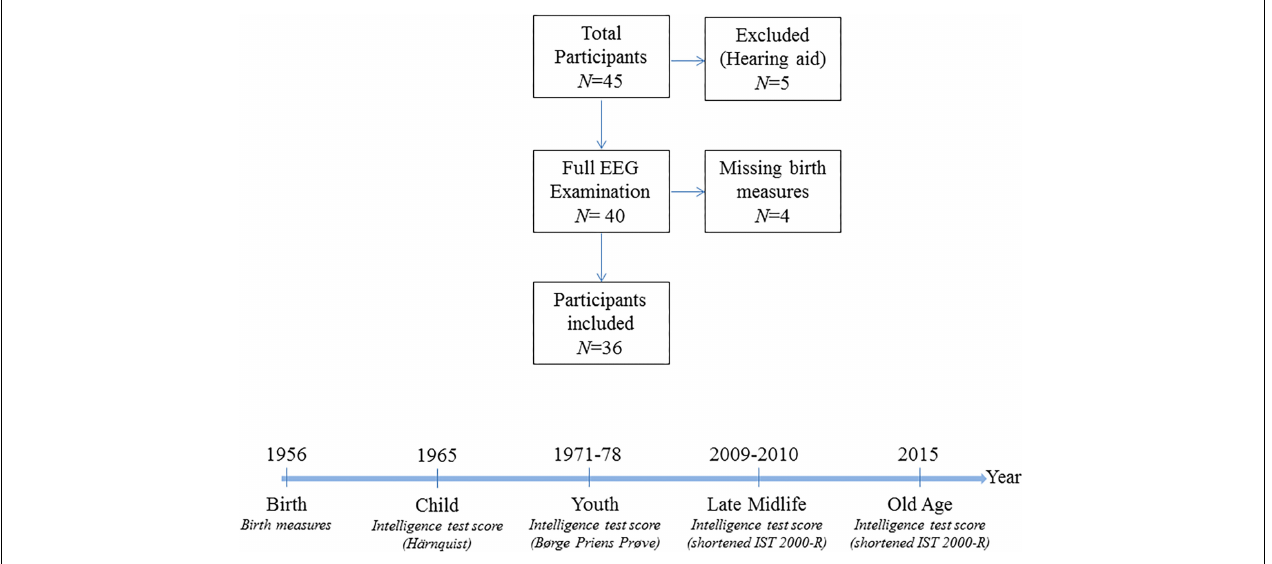
FIGURE 1 | Sample information. The upper panel is a flow chart of the sample selection procedure. The lower panel visualizes the timing of the measurements of the intelligence scores in the cohort and the type of intelligence test